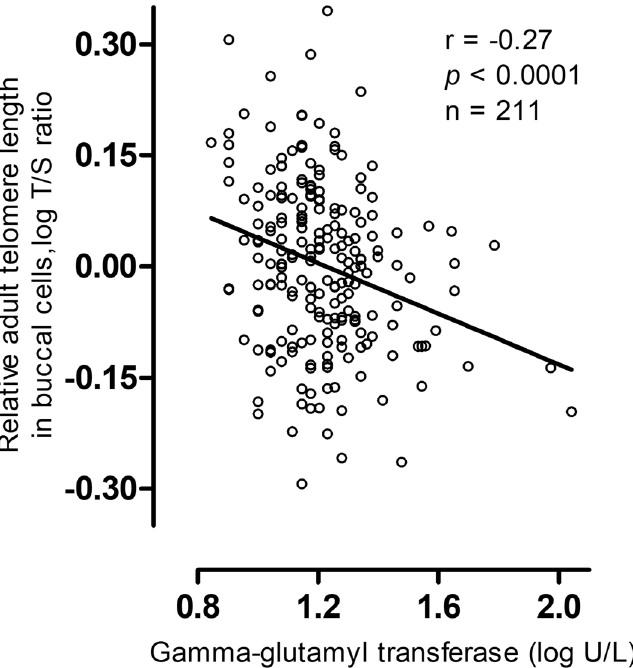
Figure 1. Gamma-glutamyl transferase in association with relative adult telomere length in buccal cells. The figure was plotted using GraphPad Prism version 5.00 (https:// www. graph pad.